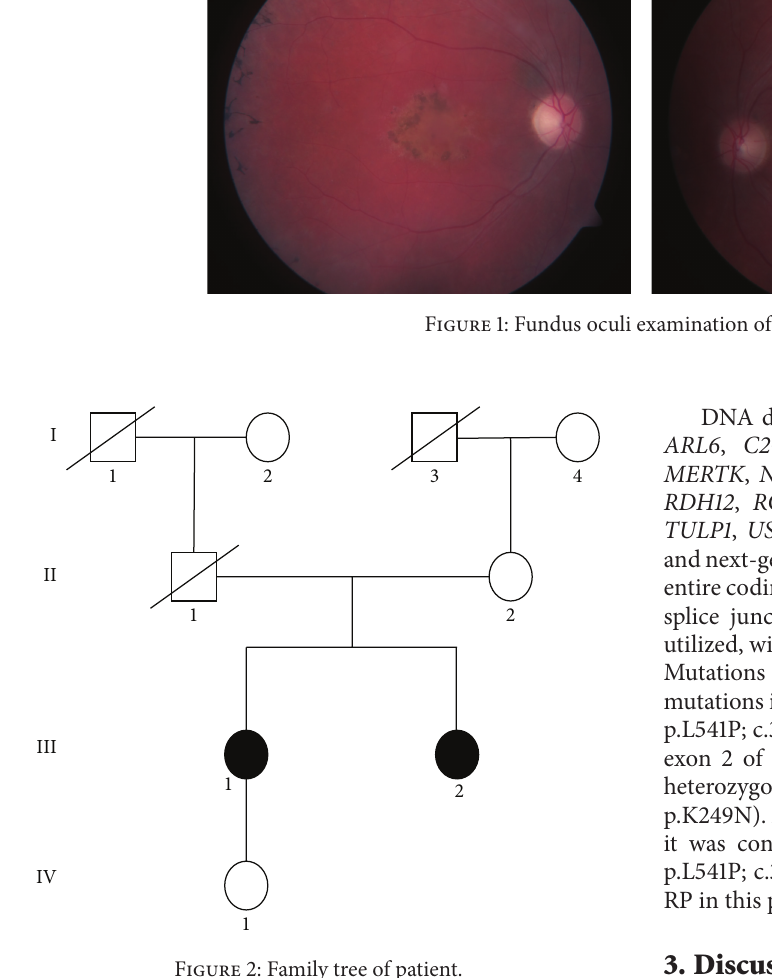
Figure 2: Family tree of